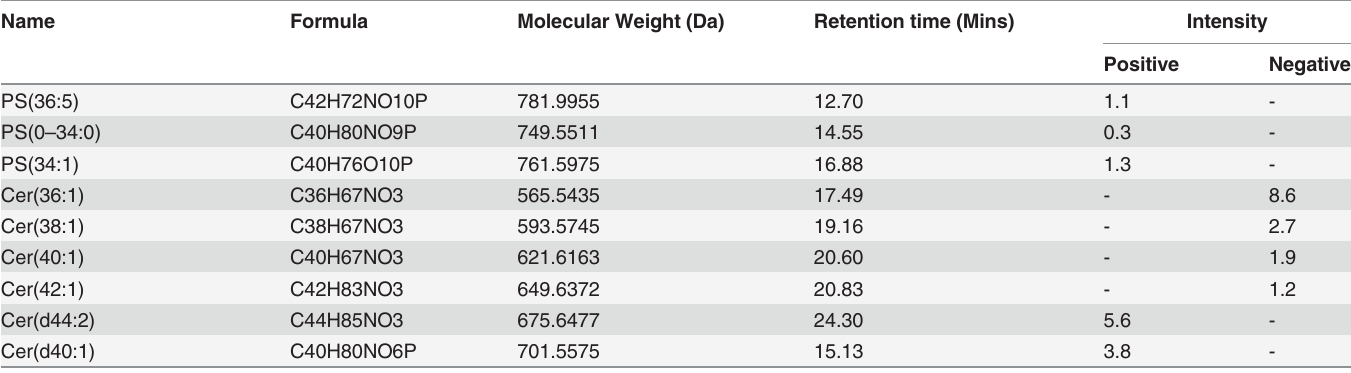
S1 Table. Measured metabolite features in the HILIC method in experiment 2. Showing the number of metabolite peaks identified and their relative variability in 100%, 93%, 87%, 80% and 73% of 15 sample replicates after transformation based on the recovery of both internal standards. a percentage of samples a peak is detected in, b coefficient of variance of peak inten- sity between